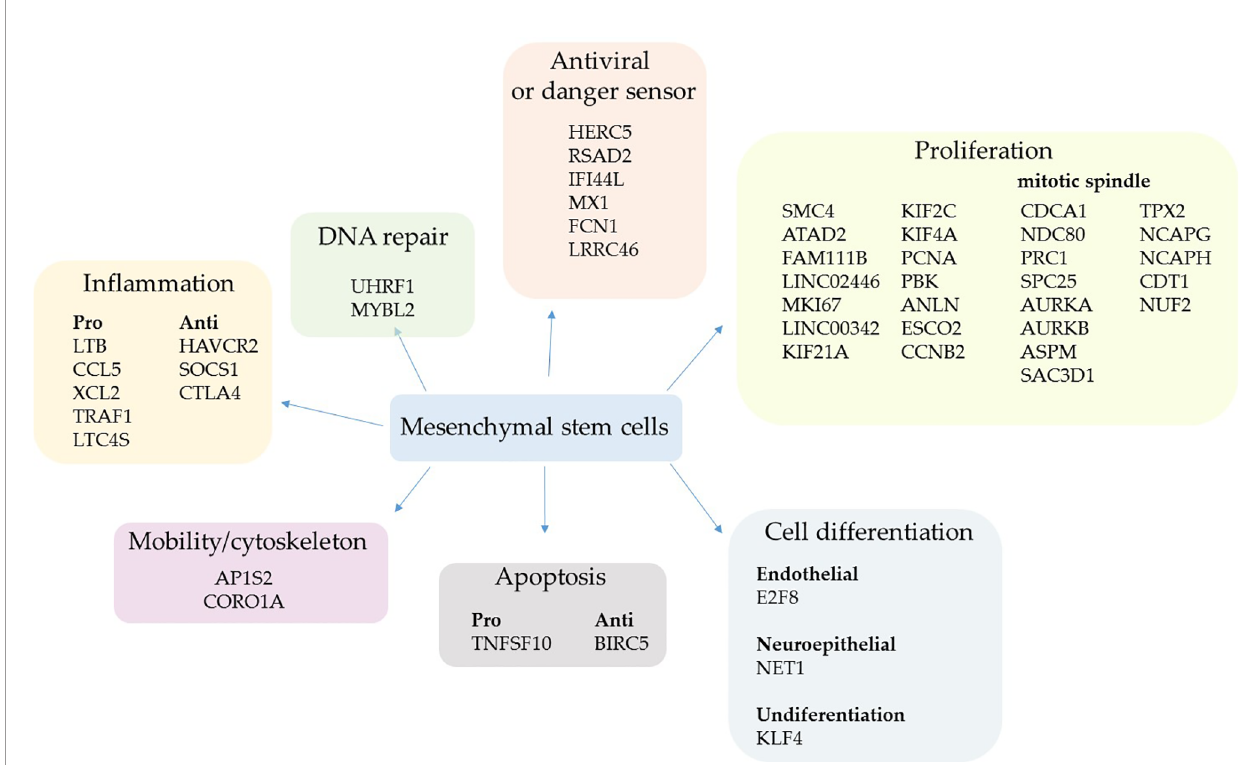
FIGURE 1 | Upregulated genes grouped by biological function in mild cases. The comparative analysis of MSCs ’ transcripts from COVID-19 patients with mild symptoms over uninfected control individuals yielded the identi fi cation of upregulated genes in sick individuals. The MSCs were analyzed in BAL fl uid and the genes were grouped according to their biological